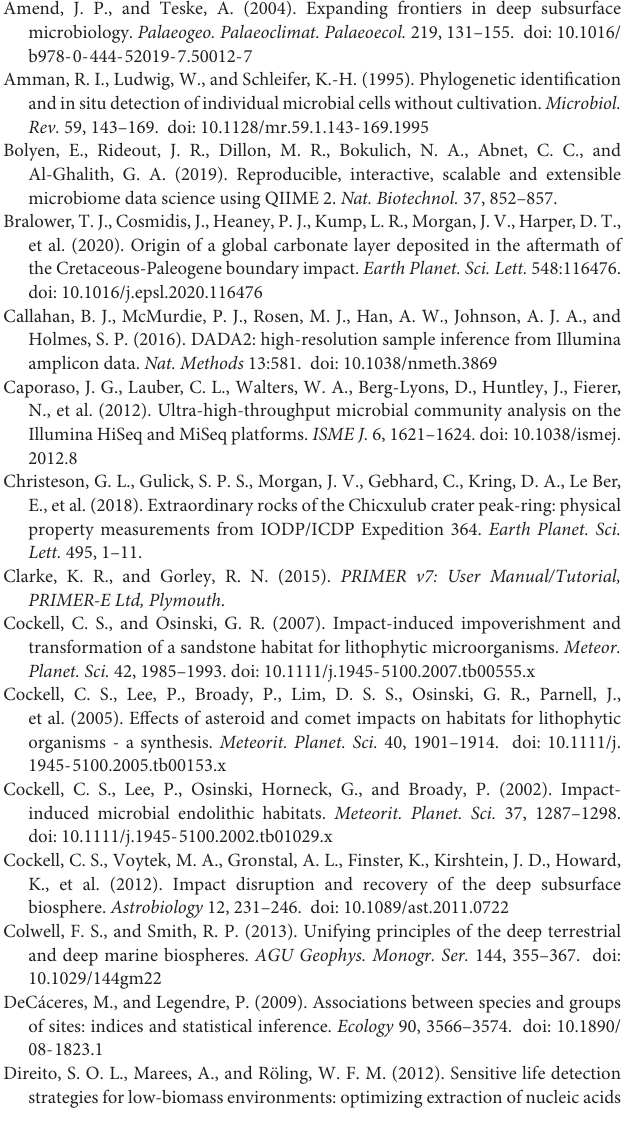
Supplementary Table 2 | ASV sequences shown in the major lithological intervals in the Chicxulub crater. Supplementary Table 3 | Pairwise permutational multivariate analysis of variance (PERMANOVA) for the relationship between microbial community composition (Bray-Curtis similarity of standardized and square root transformed) and lithology type. species analysis. Supplementary Table 6 | SIMPER analysis of contributions of major environmental parameters to microbial community